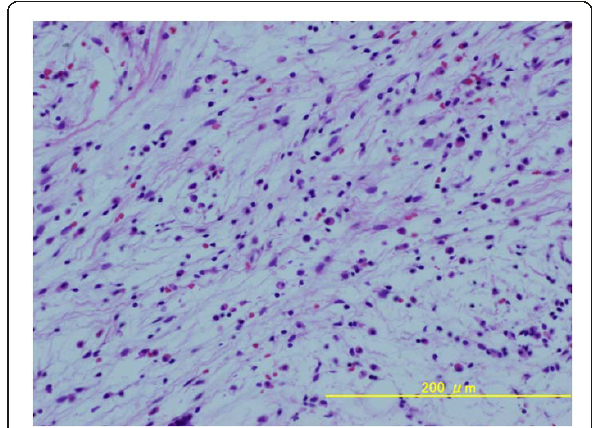
Figure 4 Histological feature of the soft tissue around the nerve root . Photomicrograph of the soft tissue around the nerve root showing infiltration by chronic inflammatory cells including lymphocytes and plasma